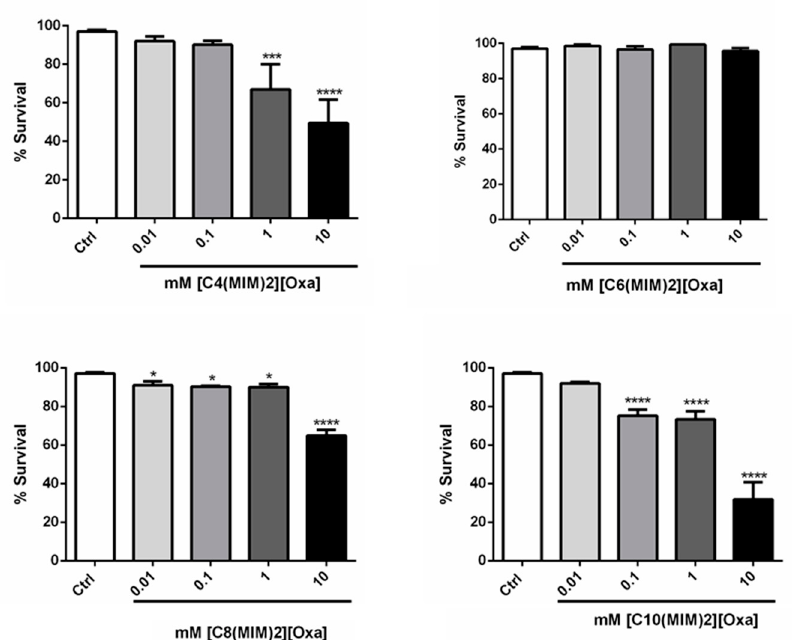
Figure 4. Survival assay for wild-type (N2) worms in different concentrations (in mM) of DILs with oxalate anion. * p < 0.05, *** p < 0.001 and **** p < 0.0001 compared to Ctrl (One-Way ANOVA fallowed by post-hoc Sidak).